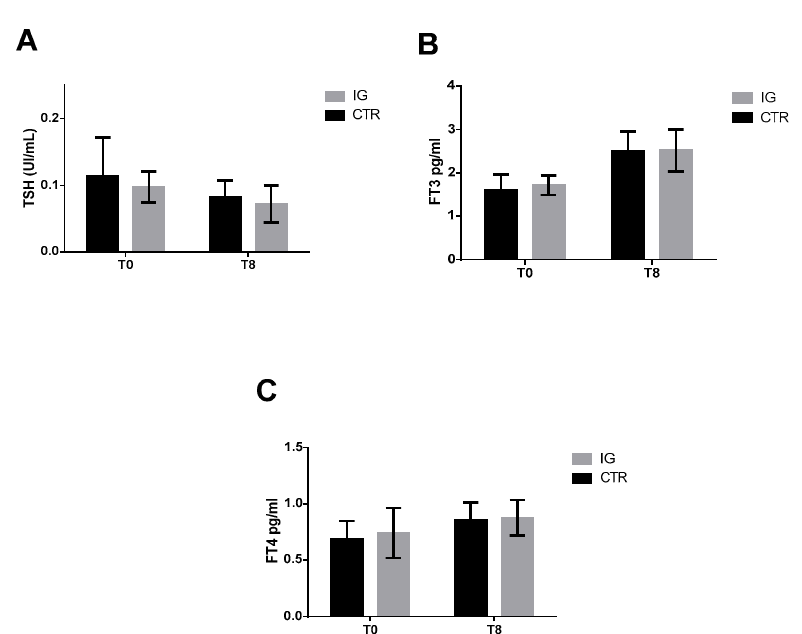
Figure 1. Thyroid hormone concentrations: Thyroid-stimulating hormone ( A ), free thyroxine ( B ), and free triiodothyronine ( C ) were measured in serum samples from control (CTR) ( n = 11) and iodine group (IG) ( n = 11) at the beginning and at the end of iodine supplementation. Data are expressed as mean ± SD, and differences were assessed using 2-way ANOVA.